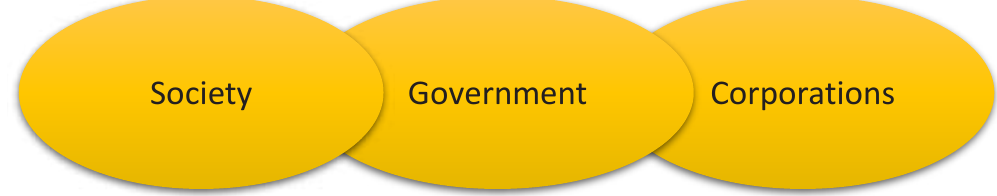
Figure 2. Interests linkage among the corporations, the government and the